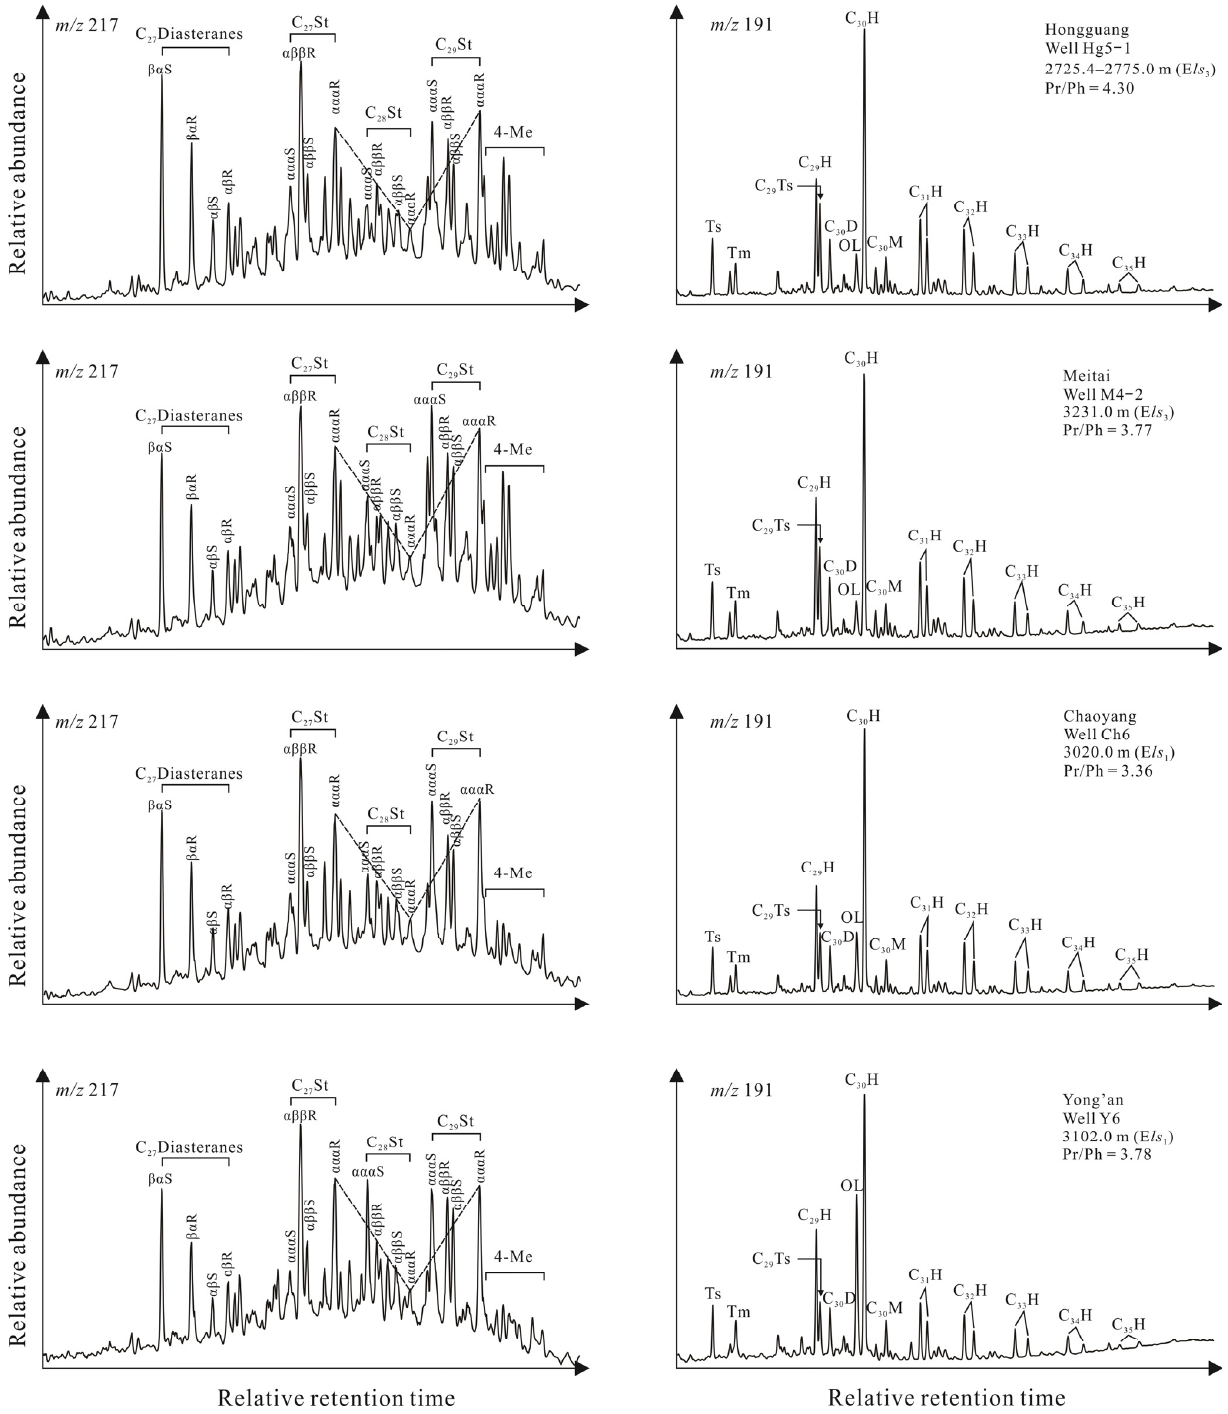
Figure 7. Mass chromatograms ( m / z 217 and m / z 191) showing the distribution of steranes and hopane series of representative oil samples. Note: C 30 H–C 34 H=C 30 hopane-C 34 hopane; Ts = 18 α - 22,29,30-trisnorneohopane; Tm = 17 α -22,29,30-trisnorhopane; C 29 Ts = 18 α -30-norneohopane; C 30 D = C 30 -diahopane; OL = oleanane. C 30 4 α -methyl-24-ethylcholestanes generally originate from dinoflagellates in a fresh- water lacustrine environment [39]. The C 30 4 α -methyl-24-ethylcholestanes/C 29 sterane val- ues of the oils from the Meitai and Hongguang area (0.42~0.57) are higher than those from